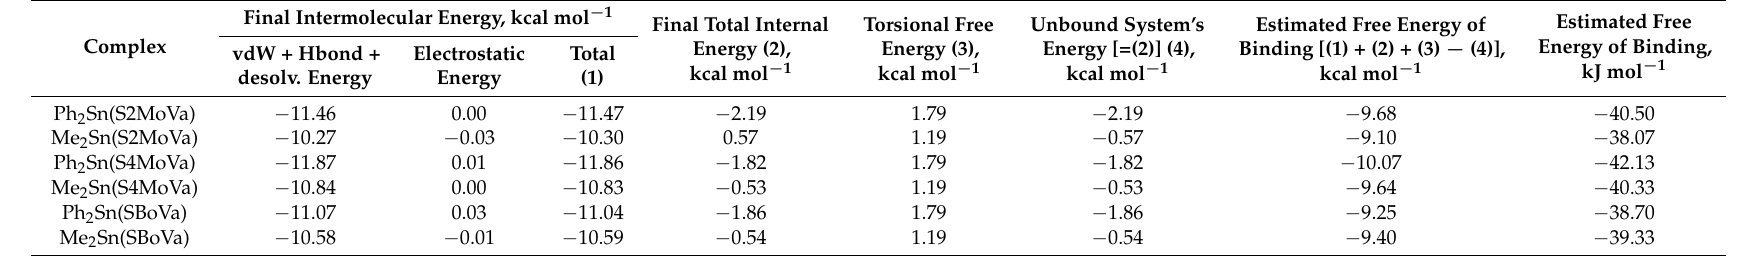
Table 4. Molecular docking data for the organotin(IV) compounds with B-DNA (PDB ID: 1BNA) dodecamer d(CGCGAATTCGCG) 2